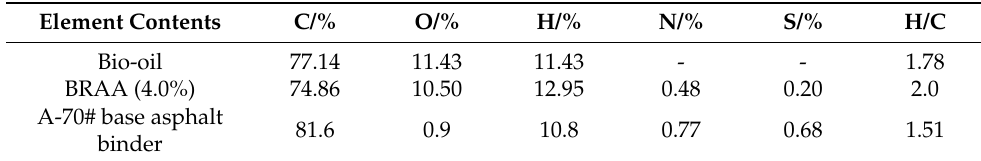
Table 4. The elemental components of bio-oil, base asphalt binder, and BRAA.